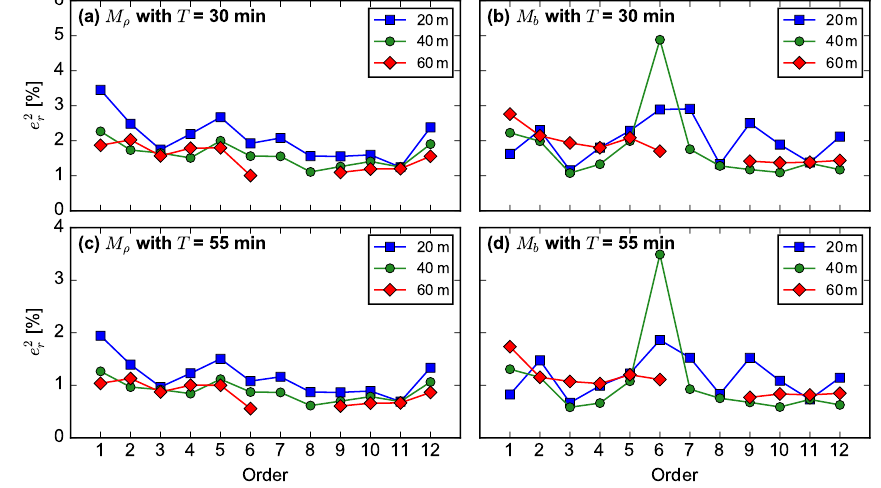
(cid:16) (cid:17) e 2 r Figure 9. The relative variance of random error for the estimated radial velocity variance from the observational data at three heights ordered by their occurrence time ( x axis). Errors in (a) and (c) are estimated using the autocorrelation method ( M ρ ) for 30 and 55min of sampling duration, respectively. Errors in (b) and (d) are estimated using the bootstrap method ( M ρ ) for 30 and 55min of sampling duration, respectively.